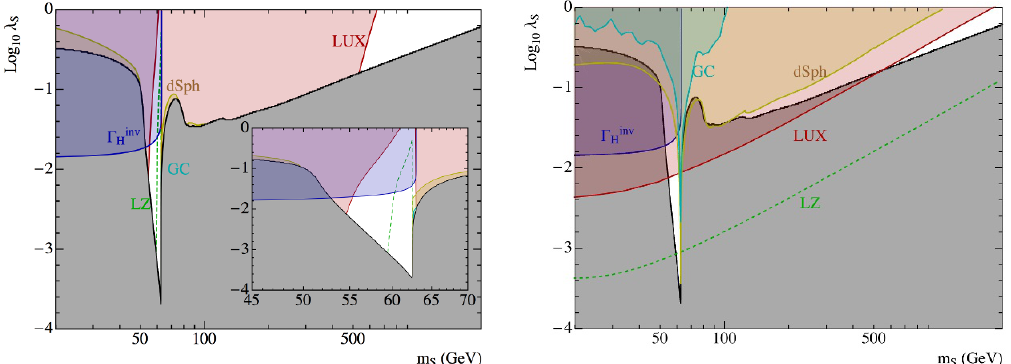
Figure 2 . Excluded regions on the parameter space of the SHP model from different experimental constraints. The gray area (below the black line) is excluded since the relic density exceeds the Planck result. The blue area (labeled Γ inv H ) is ruled out from the invisible Higgs width. The red area (LUX) is excluded by direct DM detection limits. Yellow (dSph) and cyan (GC) areas are excluded by indirect detection constraints on the continuum spectrum of gamma-rays (from dwarf Spheroidal galaxies) and monochromatic gamma-ray lines (from the Galactic Centre), respectively. The dashed green line represents the predicted reach of the future LZ detector. The left panel includes a scale factor, ξ , in the calculations while in the right plot it is assumed that some extra non-thermal effects amend the prediction for the relic density, so that ξ =